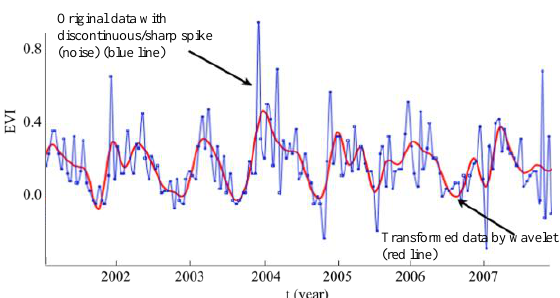
Original data with discontinuous/sharp spike (noise) (blue line)